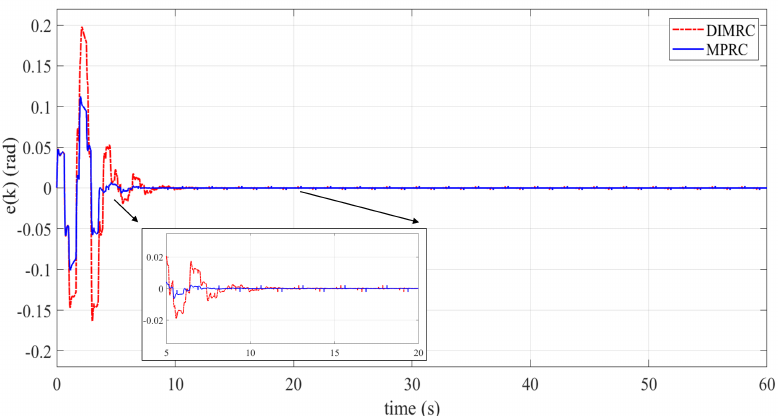
Figure 8. Tracking errors for the minimum phase system (30) with the disturbance model v 1 ( t )